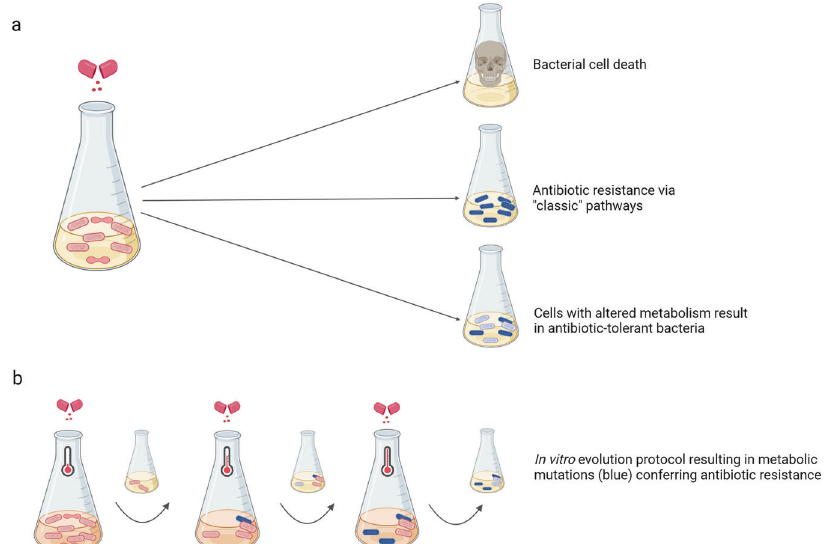
Fig. 1 a Antibiotic treatment can result in cell death, development of antibiotic resistance through target modi fi cation, drug inactivation and drug transport or mutations in core metabolic genes enriching for metabolic speci fi c pathways leading to adaptation. b In vitro evolution protocol applied by Lopatkin et al. to generate predominantly metabolic mutations. Cells were subjected to daily 1-h antibiotic treatment and 22 h of growth without antibiotics. Metabolic activity was modi fi ed by the daily increase of temperature over a period of 10